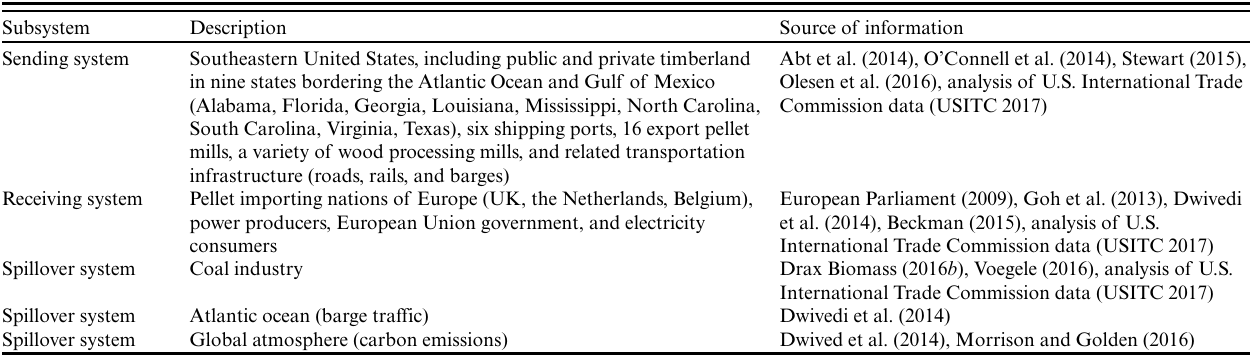
Table 1. Interacting subsystems within the telecoupled transatlantic wood pellet trade system.